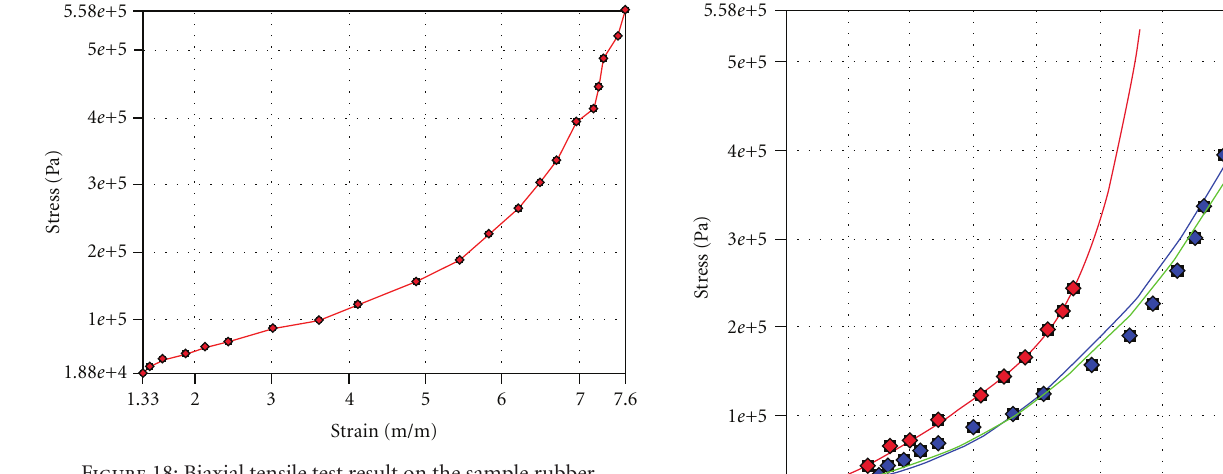
Figure 18: Biaxial tensile test result on the sample rubber.